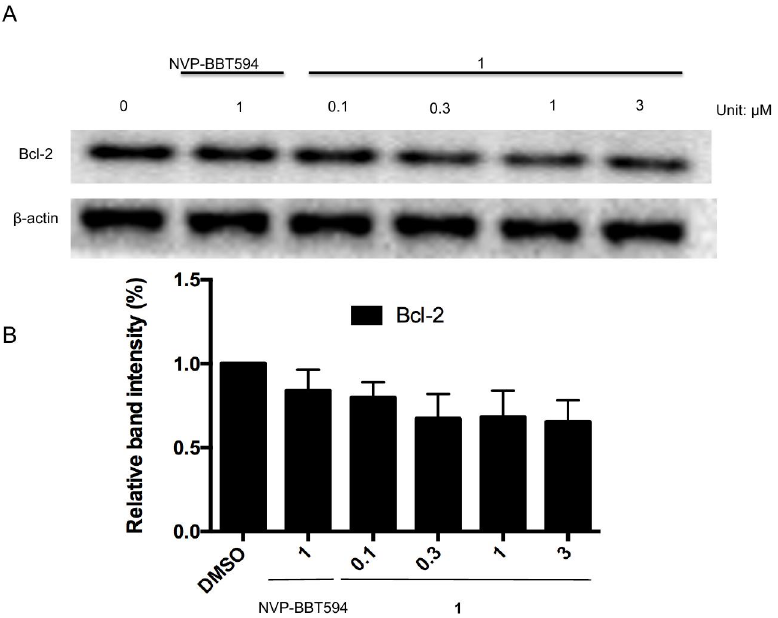
Fig 6. Effect of compound 1 on Bcl-2 level in A375 cells. (A) A375 cells were treated with the indicated concentrations of compound 1 (0.1 to 3 μ M) or positive control compound NVP-BBT594(1 μ M) for 24 h. Protein lysates were analyzedby Western blotting with the indicatedantibodies. (B) The data were analyzed using Image Lab. Error bars representthe standard deviationof triplicate results.